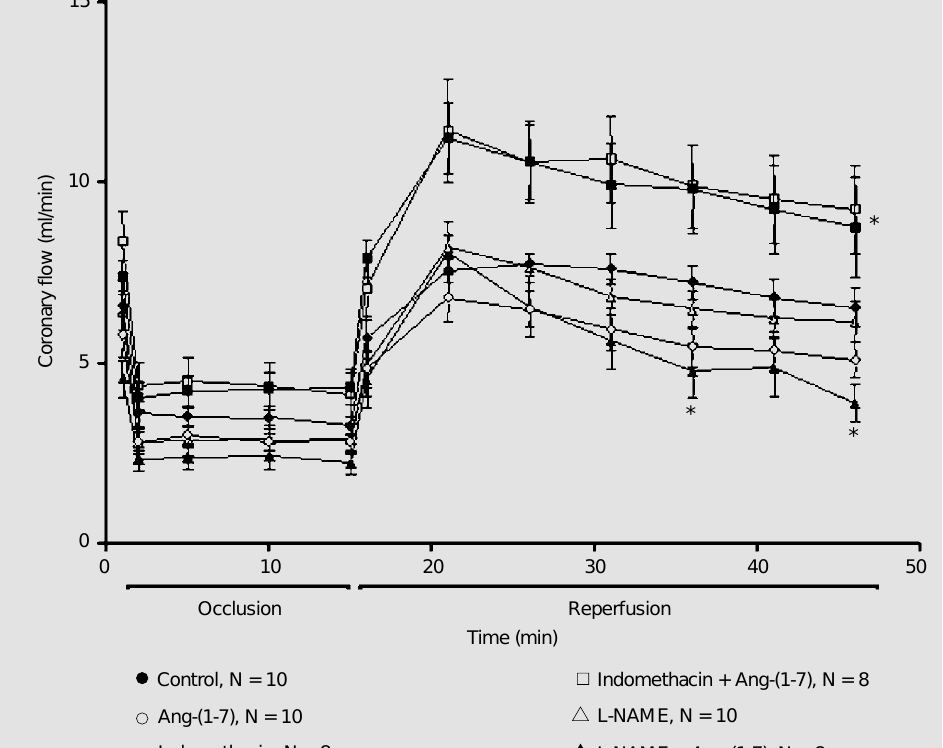
Figure 2. Effect of different an- tagonists on systolic (A) and dia- stolic tension (B) in isolated rat hearts. A-779 (2 nM, N = 9) and 100 nM HOE 140 (N = 10) were added to the perfusing solution. Indomethacin (5 mg/kg, ip , N = 8) or L-NAME (30 mg/kg, ip , N = 8) was administered 1 h before the animals were killed and hearts collected. The hearts were perfused with normal Krebs-Ringer solution (KRS) or KRS containing 0.22 nM Ang- (1-7). *P<0.05 vs untreated hearts and + P<0.05 vs respec- tive control group (Student t -